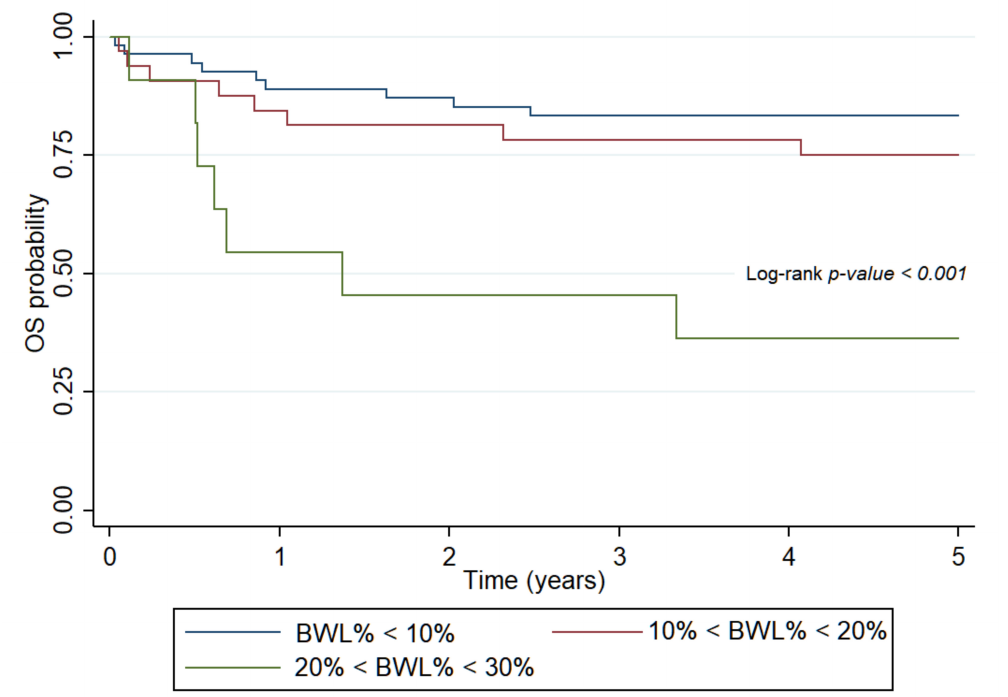
Figure 2. Probability of overall survival for patients with hematologic malignancies determined by body weight loss percent in course of treatment. OS: overall survival, BWL%: body weight loss